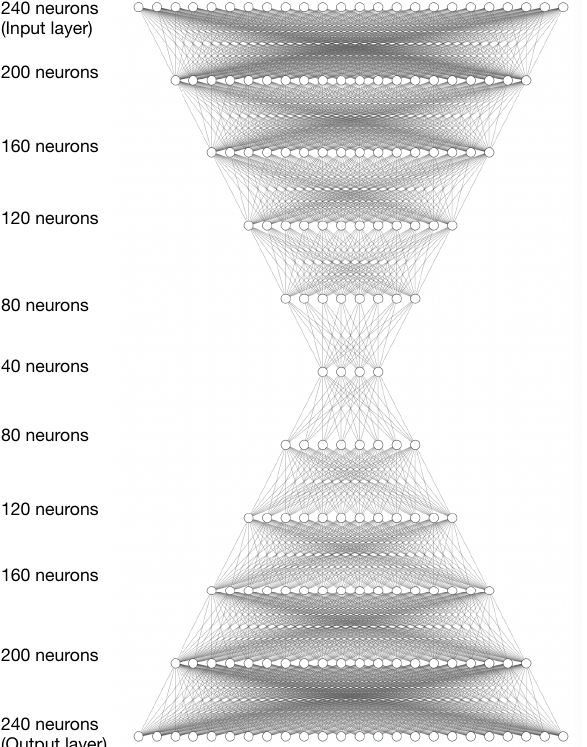
Figure 1. Example of a stacked autoencoder network architecture. This network considers five dense layers for both the encoder and decoder subnets made up of 240, 200, 160, 120, 80 and 40